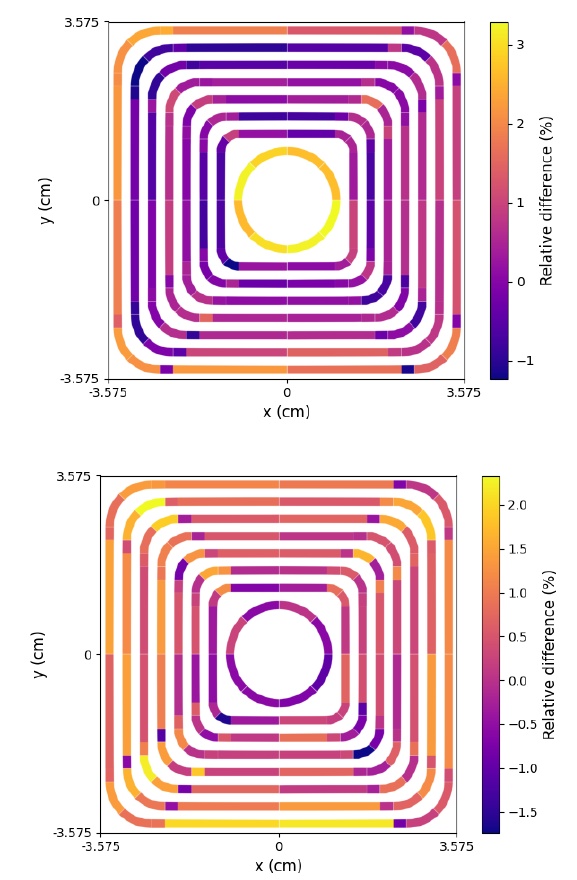
Figure 6. Relative differences between RBF-based power reconstruction and reference data for Cartesian meshes 9 × 9 (top) and 17 × 17 (bottom), both for fuel assembly in